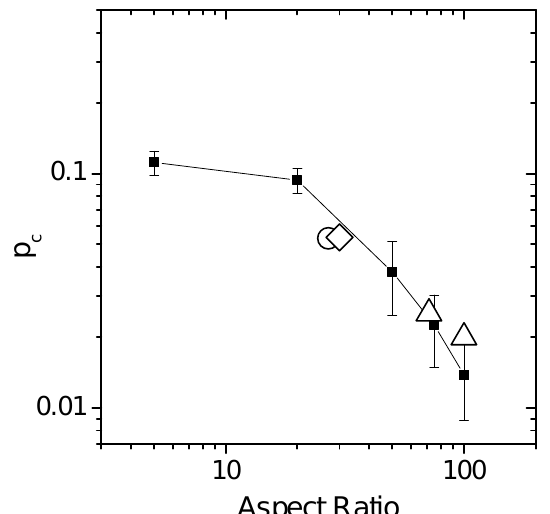
Figure 5. Dependence of the percolation concentration on the aspect ratio of the ellipsoid ( b 3 = 2.38 and n = 3). Experimentally observed percolation concentrations: (cid:52) —[36]; (cid:13) —[37] ; ♦ —[38].